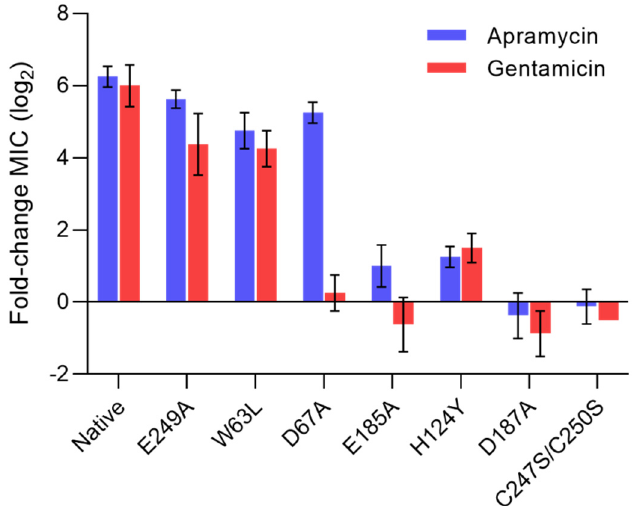
Figure 3. Functional assessment of native and mutant protein AAC(3)-IV. Phenotypic susceptibility to apramycin and gentamicin in recombinant E. coli strains displayed as fold-changes in minimal-inhibitory-concentration (MIC) relative to a susceptible wild-type strain lacking aac(3)-IV (mean ± SE; n =